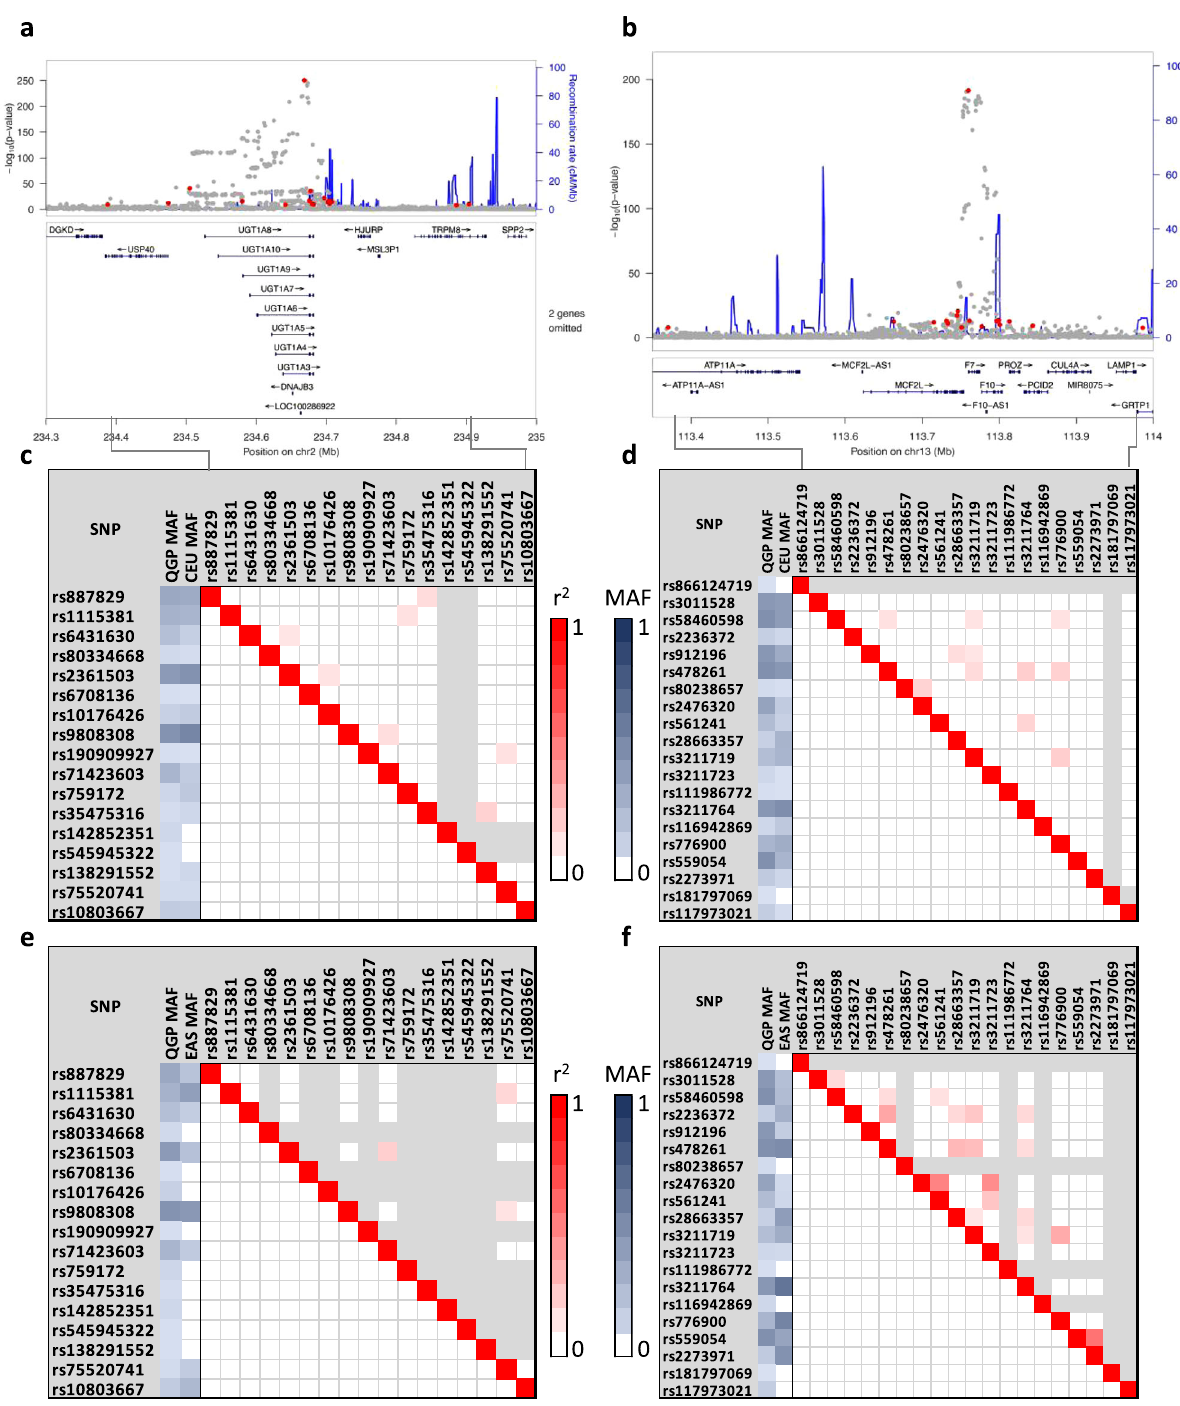
Fig. 3 Comparison of allele frequency and linkage disequilibrium patterns. Example of multiple distinct signals identi fi ed at loci associated with clinically- relevant traits. a Regional association plots for total bilirubin (Tbil) locus on chromosome 2 and ( b ) the prothrombin time (PT) locus on chromosome 13. The plots show chromosomal positions of SNPs plotted against – log 10 (P). Multiple distinct signals are shown as red circles, blue lines represent recombination rate. c – f Comparison of allele frequency and linkage disequilibrium for the distinct signals between QGP and European population ( c and d ) or between QGP and East Asian populations ( e and f ) for the Tbil and PT loci. Linkage disequilibrium patterns between the distinct signals from QGP data are shown below the red diagonal boxes and those from European ( c , d ) or East Asian ( e , f ) populations are shown above the diagonal red boxes. Grayed areas indicate monomorphic SNPs. MAF indicates minor allele frequency from QGP, European (CEU) or East Asian (EAS) for traits with available scoring data in the Polygenic Score Cat-